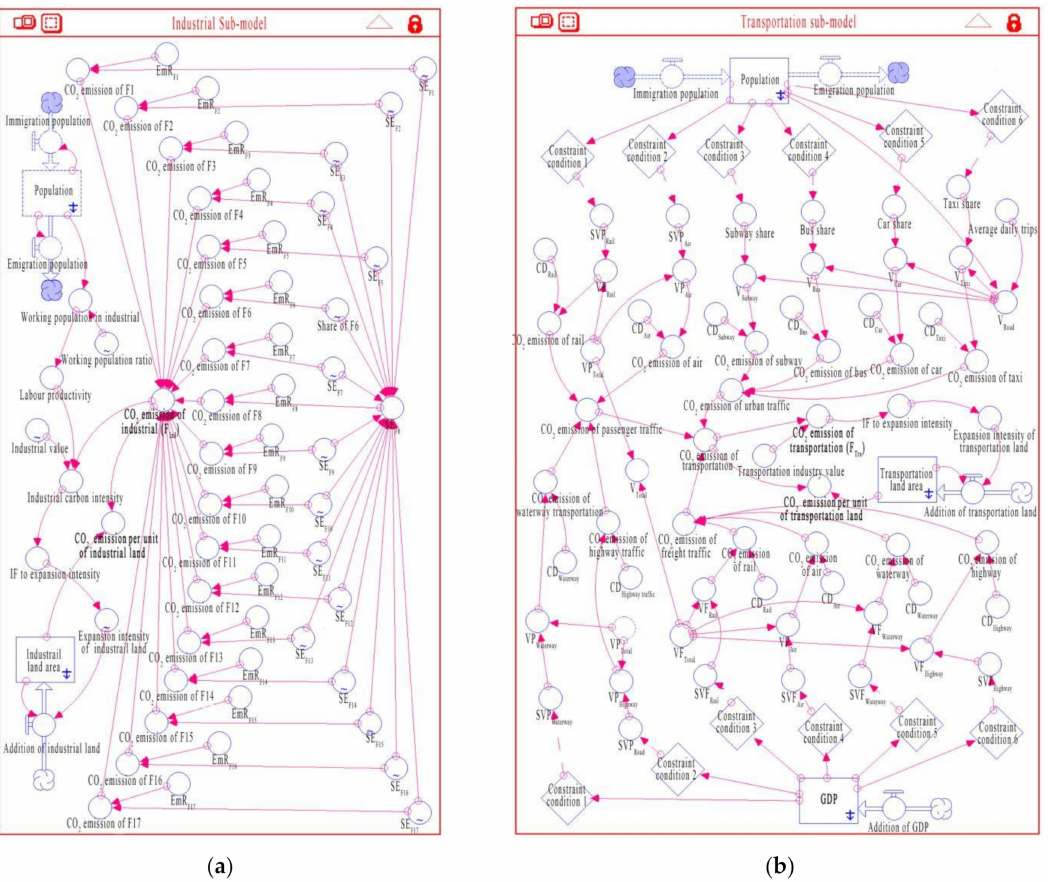
Figure 4. The CO 2 emissions stock and flow diagram. ( a ) Industrial sub-model. ( b ) Transportation